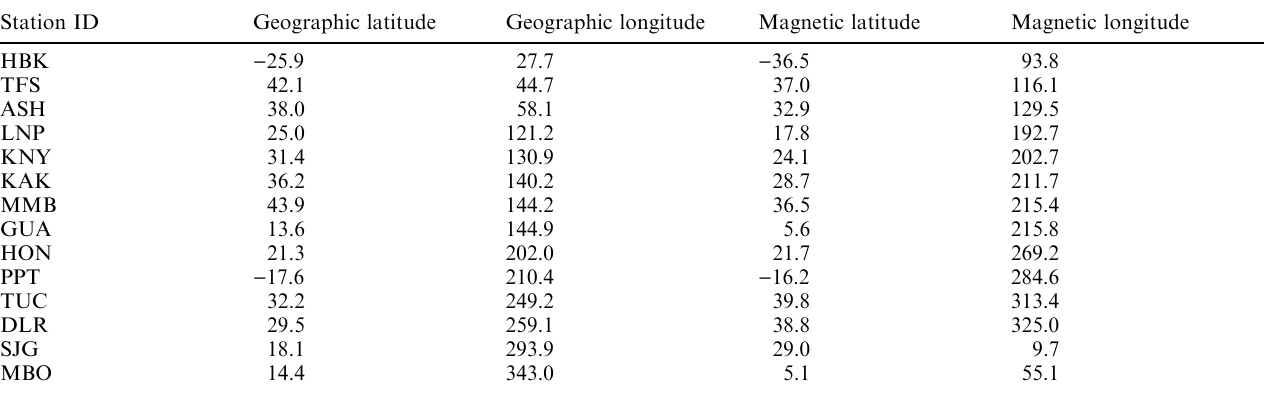
Table 1. Table presenting the geographic and geomagnetic locations of the 14 magnetometer stations used to construct Dst employed in this study Station ID Geographic latitude Geographic longitude Magnetic